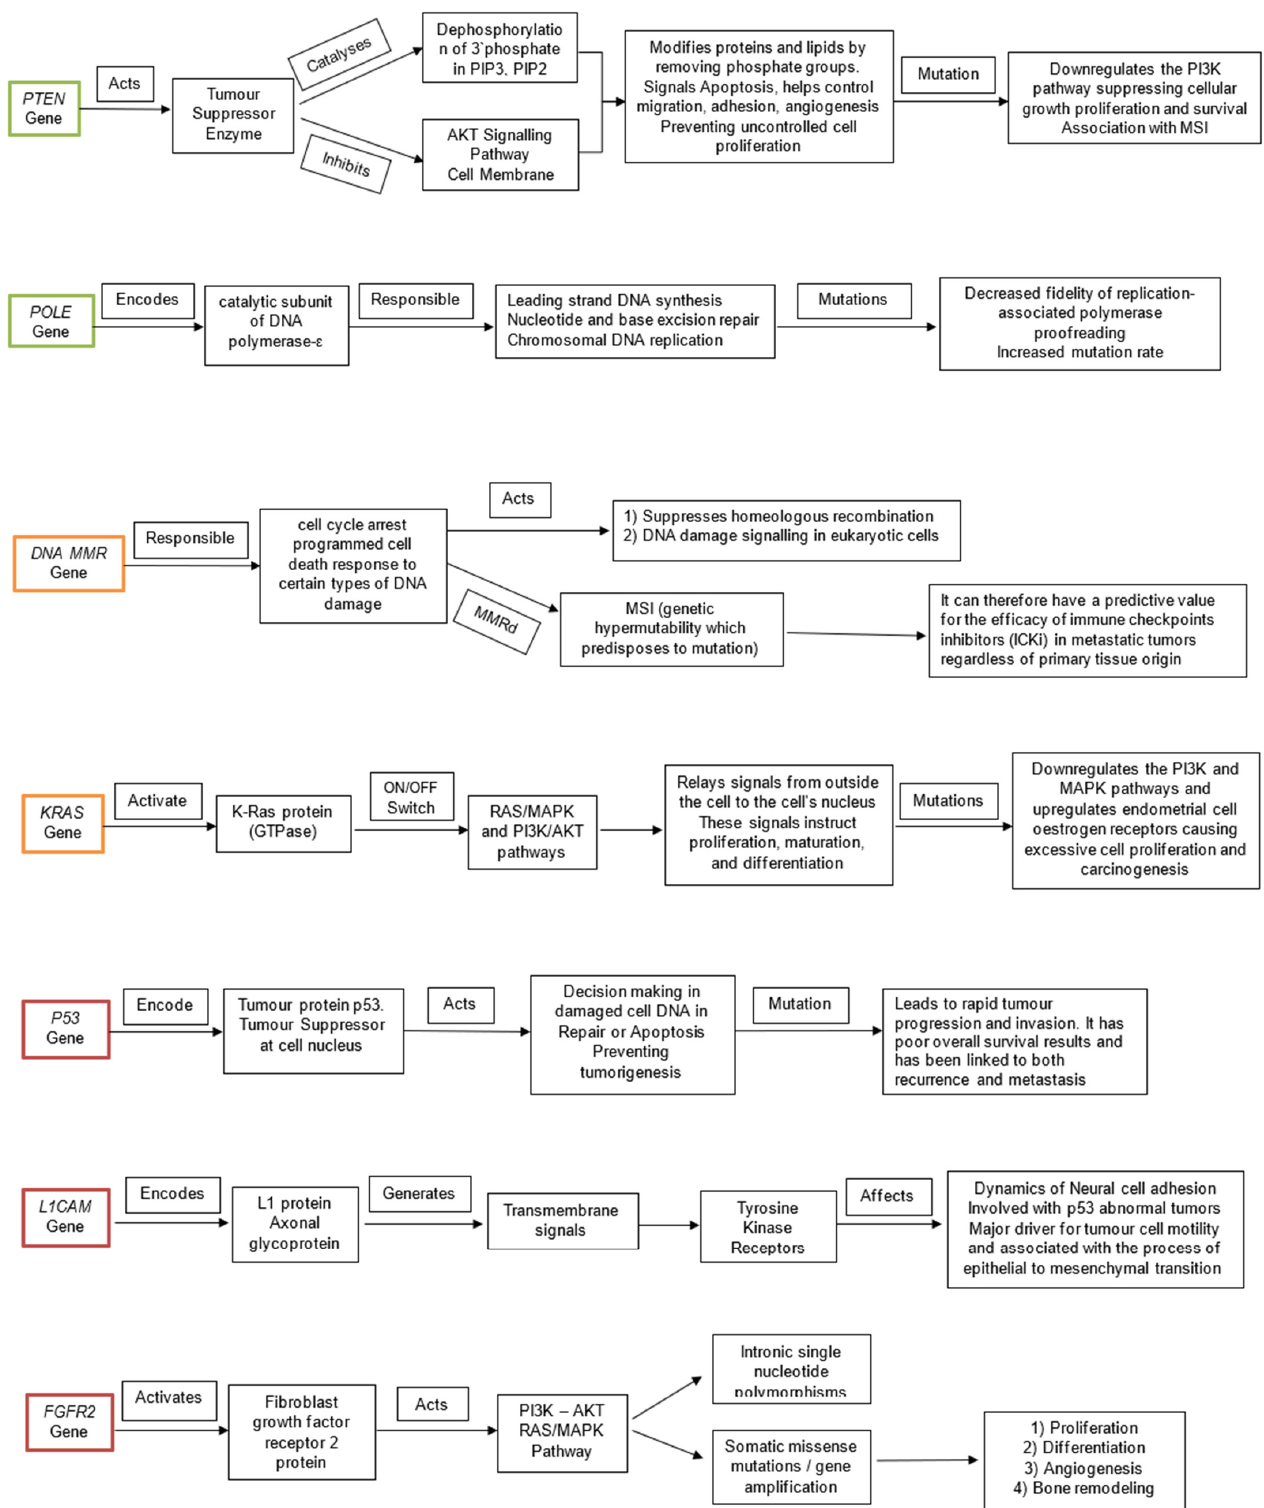
Figure 2. Visual representation of the functions of each gene ( PTEN, POLE, MMR, KRAS, P53, L1CAM, FGFR2 ) and the pathological consequences of their mutations. The genes are colour coded according to prognostic ability good (green), fair (amber), poor (red).